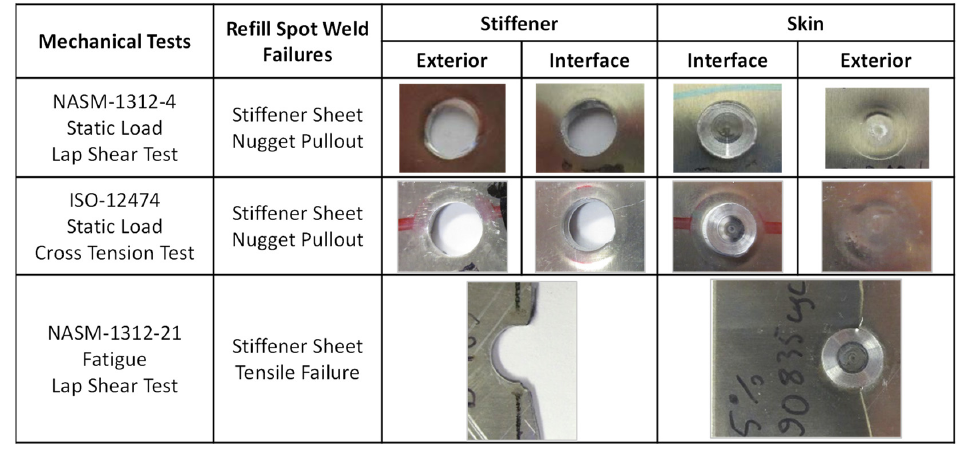
Figure 14. Mechanical failures of refill spot welds.